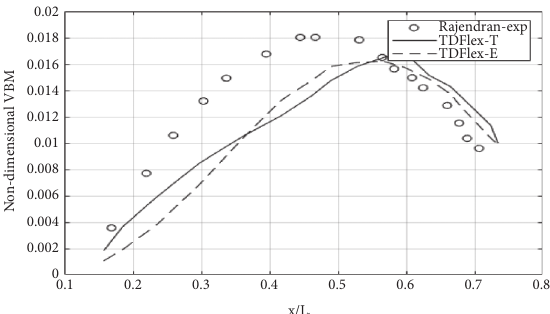
Figure 8: VBMs along the length for LC ( F